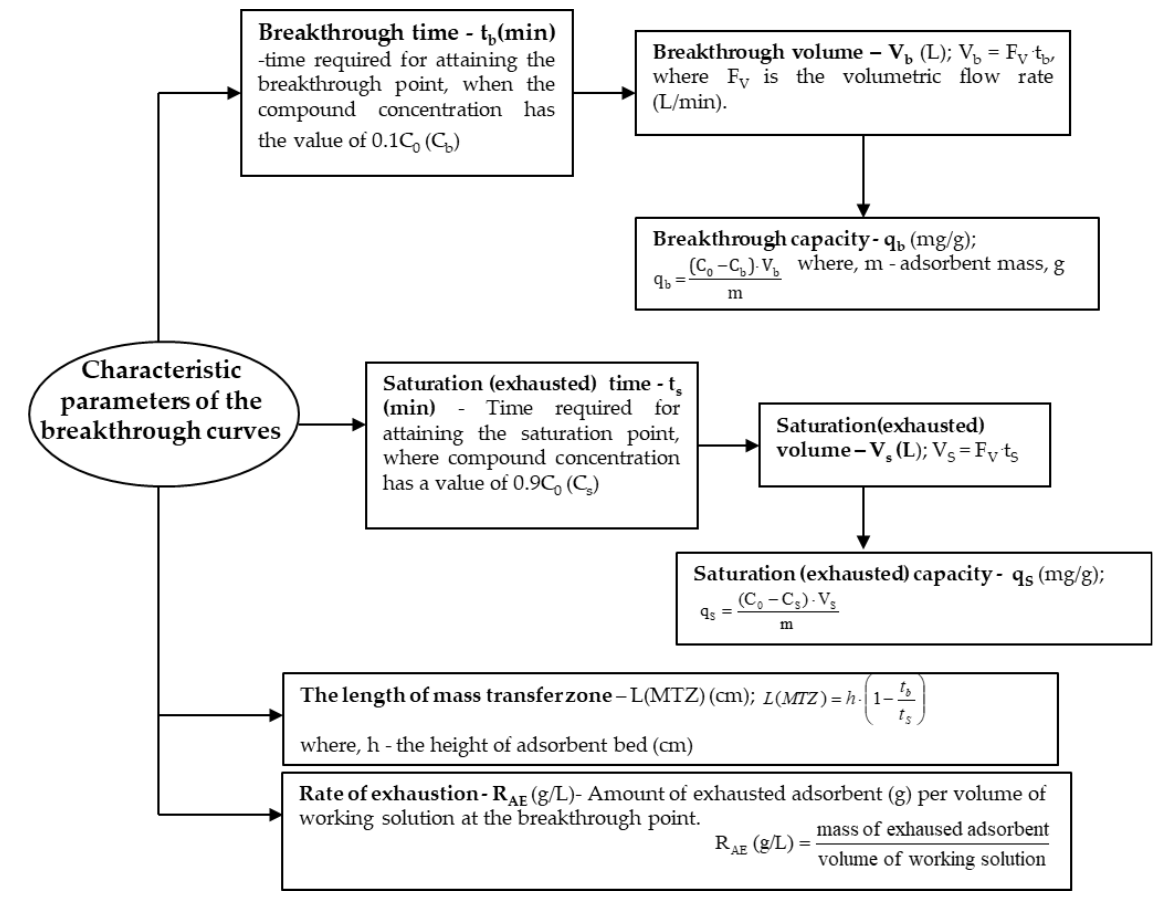
Figure 3. Characteristic parameters of the breakthrough curves [59,126,127]. Table 1. Characterization of dynamic biosorption systems for inorganic and organic pollutant re- moval via the parameters of breakthrough curves.